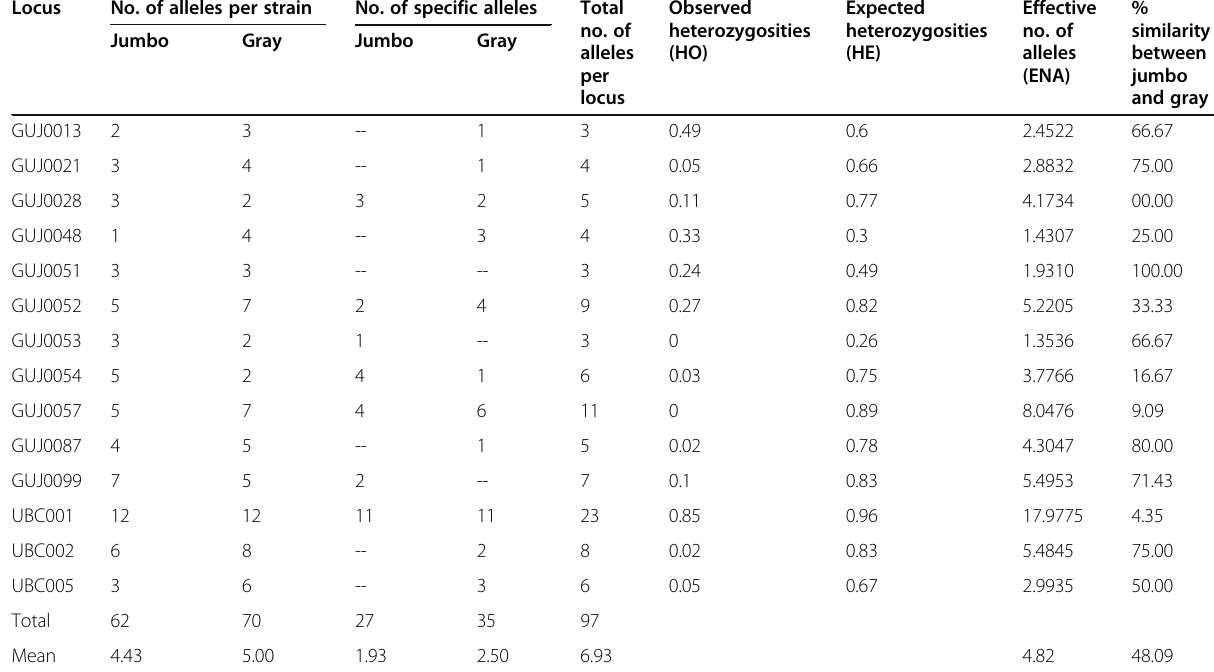
Table 5 Number of alleles observed for each locus within each quail strain, total no. of alleles, specific alleles, observed (HO) and expected (HE) heterozygosities, effective number of alleles (ENA), and similarity between jumbo and gray Japanese quail strains Locus No. of alleles per strain